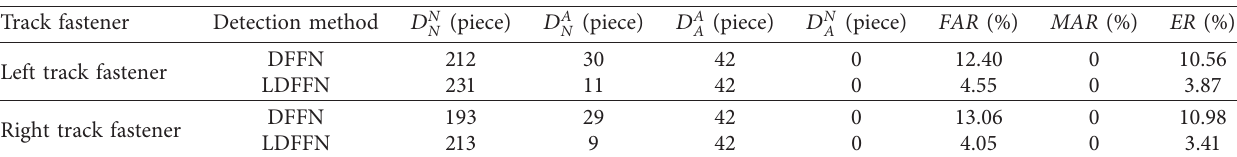
Table 3: Defect detection results of Pandrol track fasteners based on LDFFN.